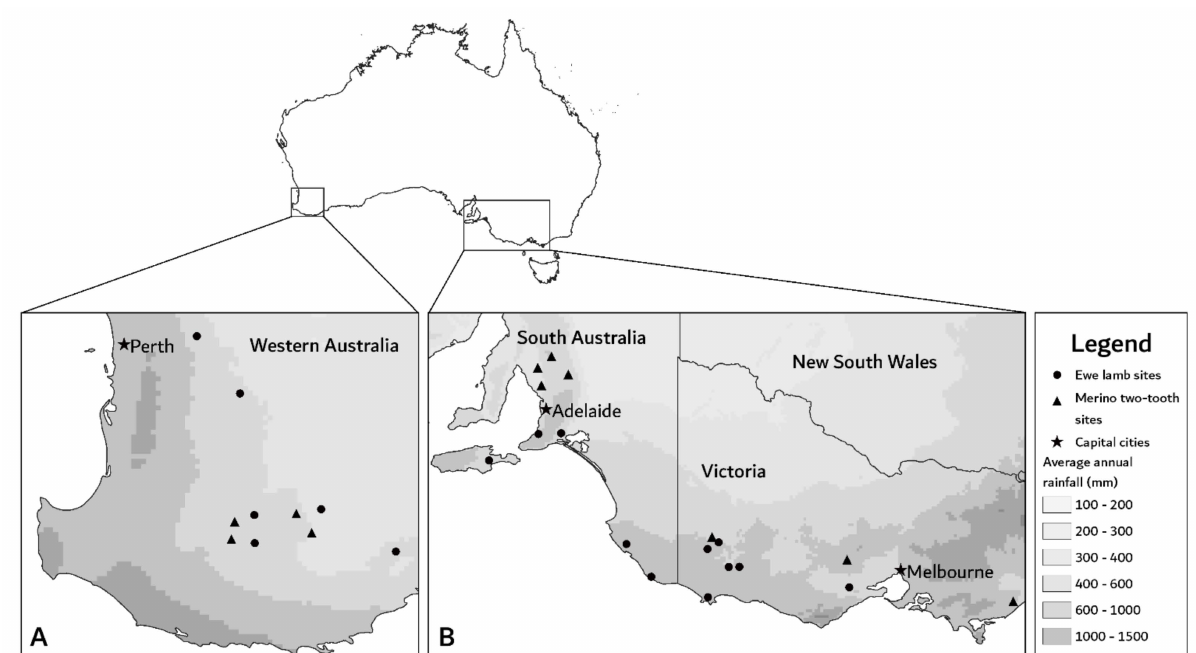
Figure 1. Approximate location of each farm where maiden ewes were monitored in ( A ) Western Australia and ( B ) South Australia and Victoria. Data for average annual rainfall was sourced from Australian Government Bureau of Meteorology